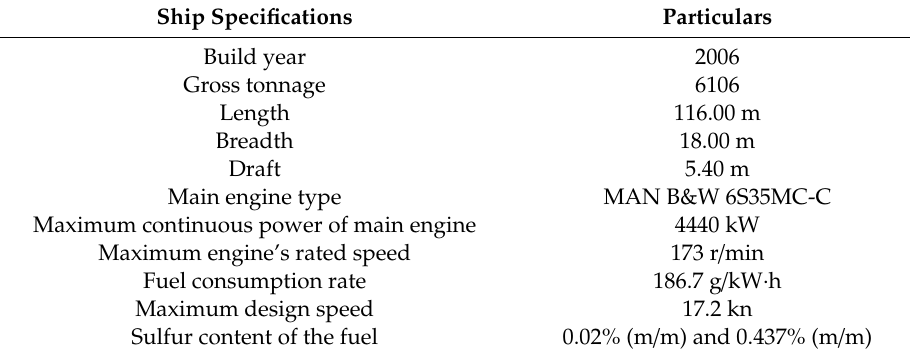
Table 3. Specifications of the test